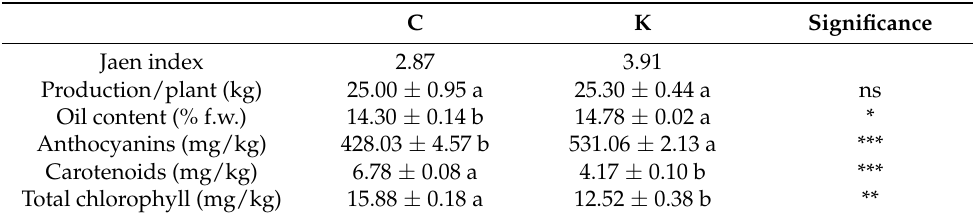
Table 1. Production/plant, Jean index, oil content (%), anthocyanins (mg/kg), carotenoids (mg/kg), and total chlorophyll at the time of drupe harvest treated with kaolin product (K) compared with the control (C).